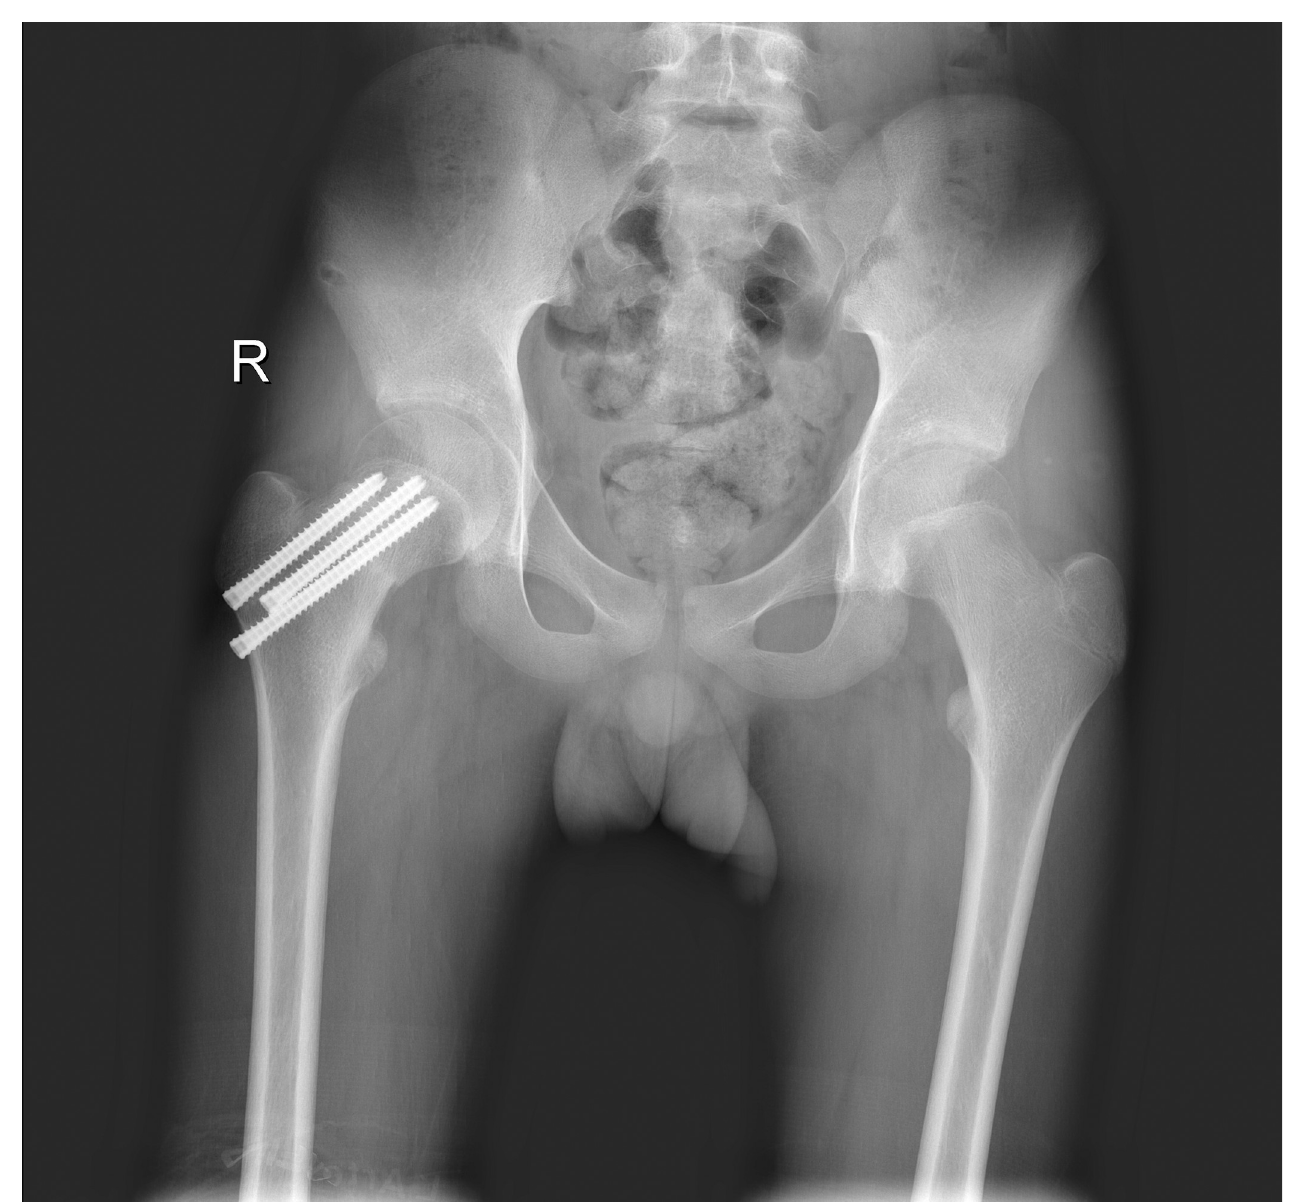
Fig 5. Reduction quality. Satisfactory reduction: The fractures ends have good alignment, no displacement and no angle.